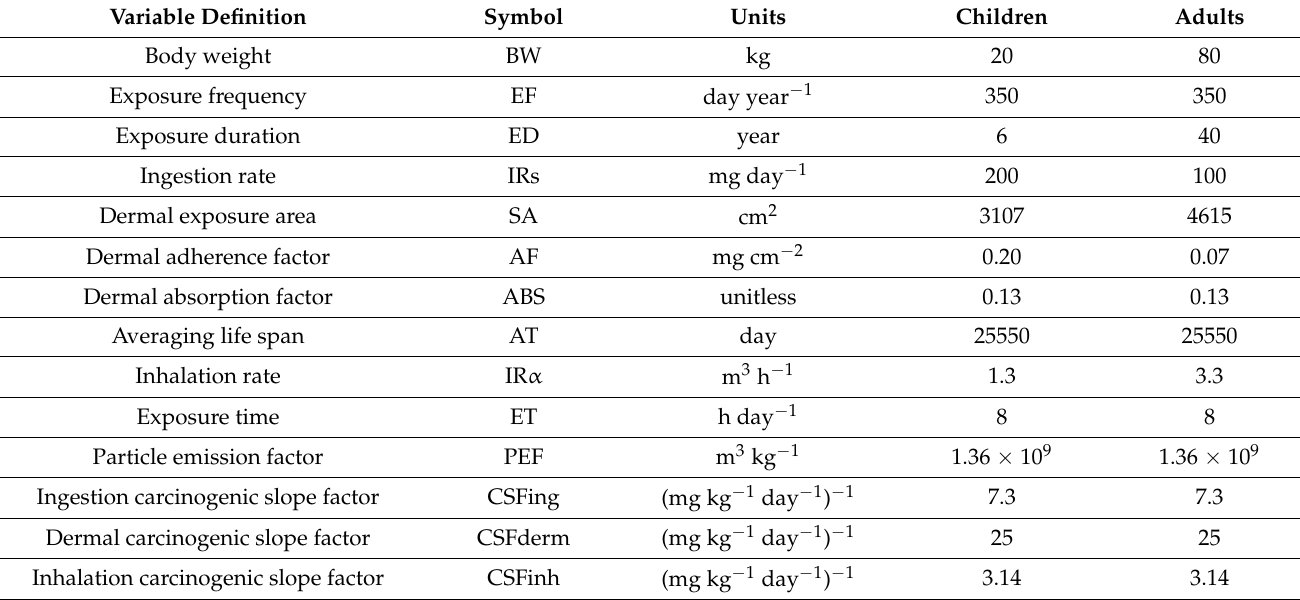
Table 1. Parameters used to calculate cancer